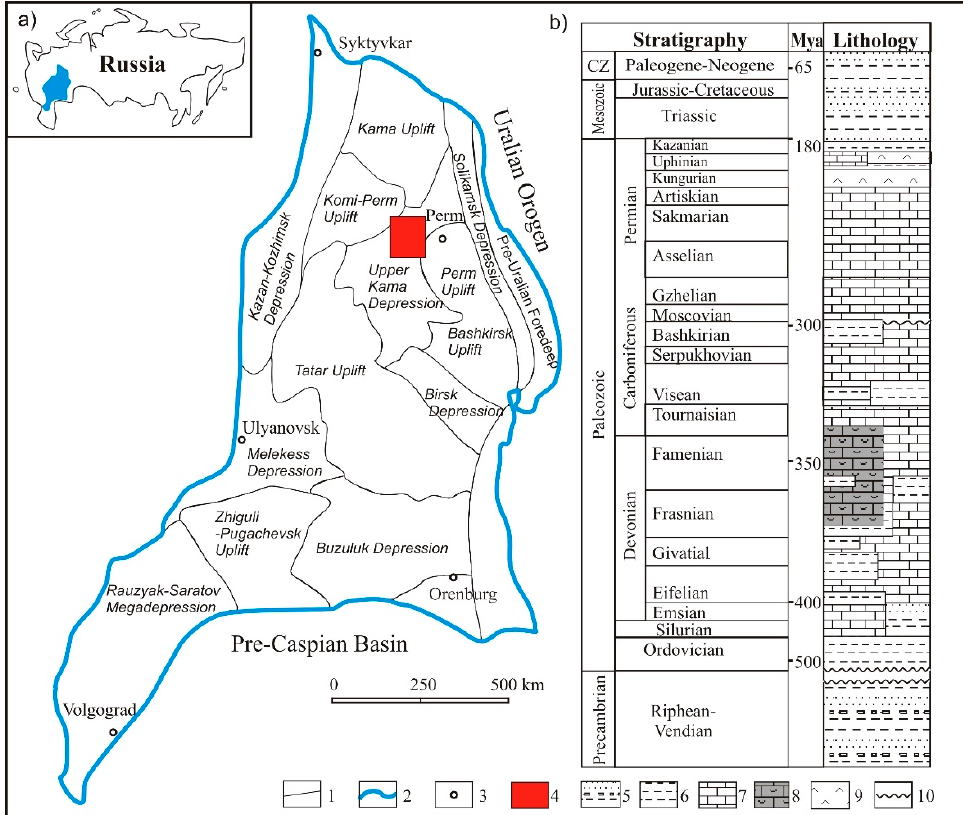
Figure 1. Location map of the Volga–Ural Basin showing tectonic elements ( a ); stratigraphic column for the study area ( b ) (modified from [11]). Legend: 1—boundary of tectonic units (uplifts and depressions within the Volga-Ural Basin); 2—boundary of Volga-Ural Basin; 3—city; 4—study area location, 5—conglomerate, sandstone and argillite; 6—argillite; 7—limestone; 8—organic-rich siliceouse limestone; 9—salt deposits; 10—unconformity.